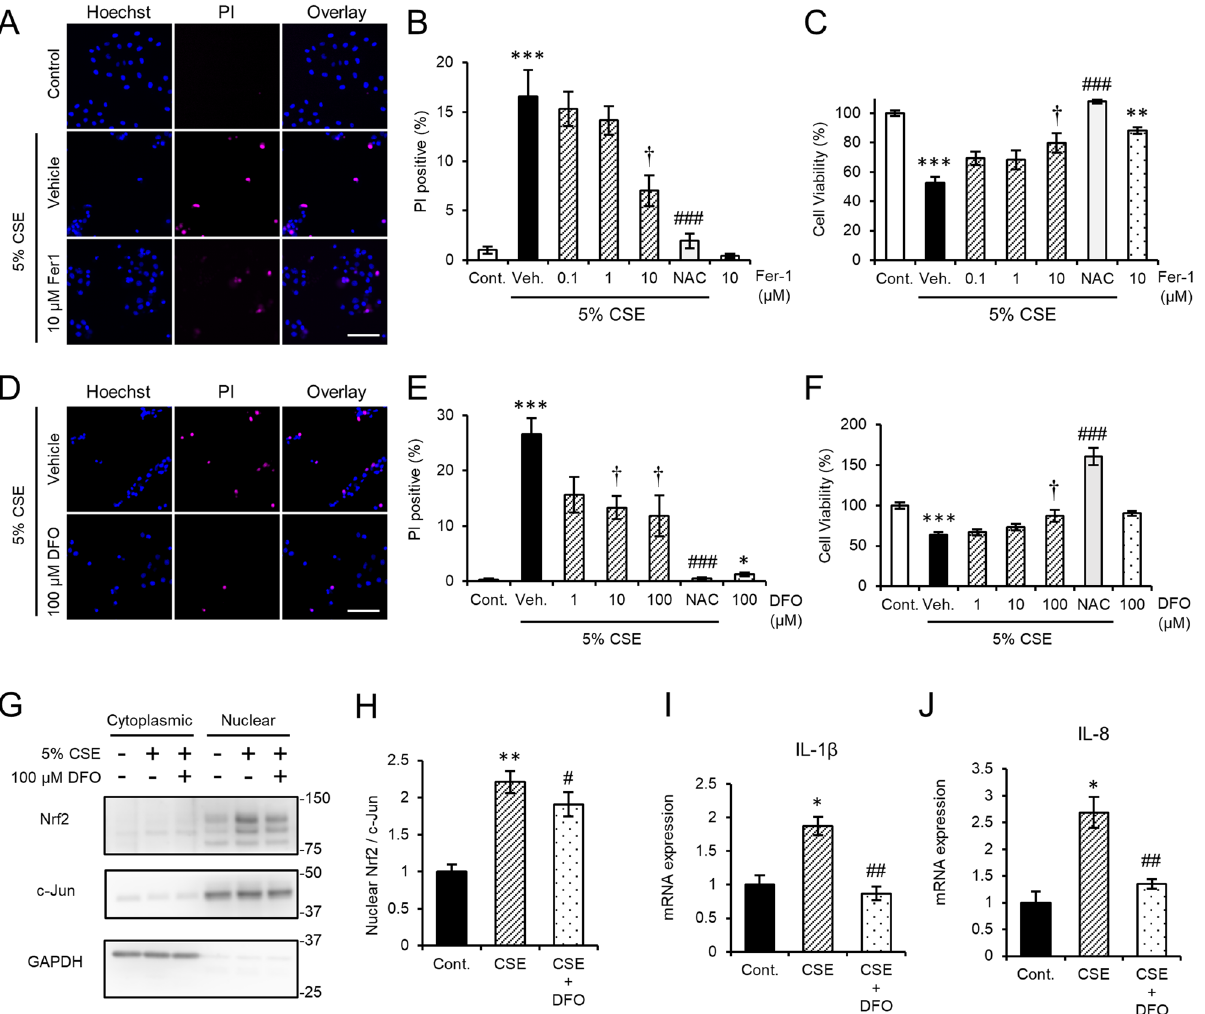
Figure 4. Fer-1 and DFO have protective effects against CSE-induced HCE-T cell damage. ( A , D ) Representative images of Propidium Iodide (PI, magenta) and Hoechst 33342 (blue) staining after CSE exposure in the presence or absence of Fer-1 ( A ) or DFO ( D ). Bars = 100 µm. ( B , E ) The bars show the PI-positive cell ratios. ( C , F ) Cell viability was measured with a Cell Counting Kit-8 (CCK-8) assay. ( G , H ) Subcellular fractionation showing the nuclear Nrf2 levels in HCE-T cells exposed to 5% CSE with or without 100 µM DFO treatment for 6 h. ( H ) Quantification of the nuclear Nrf2 levels shown in ( G ). The Nrf2 signals were normalized to the c-Jun signals. ( I , J ) IL-1β ( I ) and IL-8 ( J ) mRNA levels in DFO-treated HCE-T cells exposed to CSE. The data are represented as the mean ± SEM (n = 6). * P < 0.05, ** P < 0.005, *** P < 0.001, Student’s t -test vs. Control (Cont); † P < 0.05, Dunnett’s test vs. Vehicle (Veh); # P < 0.05, ## P < 0.005, ### P < 0.001, Student’s t -test vs. Vehicle (Veh) or